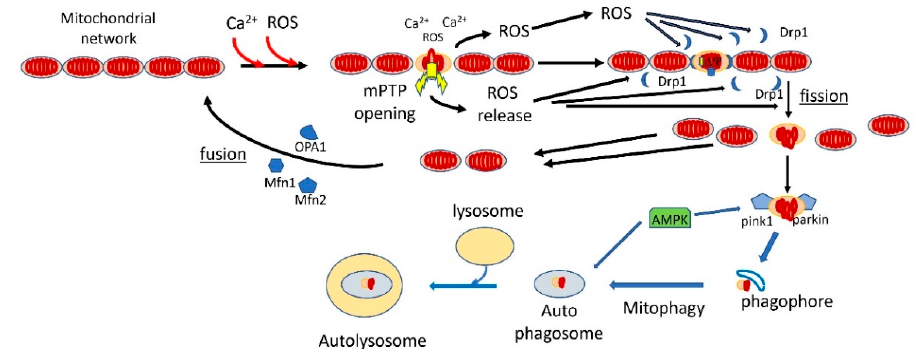
Figure 2. Mitophagy retards aging by clearing mitochondrial fragments with fully activated mPTP. In young normal cells, the mitochondria are connected in a mitochondrial network. With aging, increased mROS production and mitochondrial calcium overloading fully activate mPTP in some mitochondria. The mROS released by mPTP induces mitochondrial fission by recruiting dynamin-related protein 1 (Drp1) to contact sites between the mitochondria. The depolarized, mPTP-damaged fragments recruit PINK1 and Parkin, which leads to ubiquitination of the mPTP-damaged fragments, labeling them for mitophagy. The mROS produced by mPTP activation also activate AMPK, which enhances autophagy/mitophagy. The damaged, mitophagy-labeled fragments are then engulfed by the phagosome, which progresses into autophagosomes. These are taken out by lysosomes, where the damaged mitochondrial fragments are degraded. The undamaged fragments recruit OPA1 and mitofusins and are fused back, together with newly synthesized mitochondria, into the mitochondrial